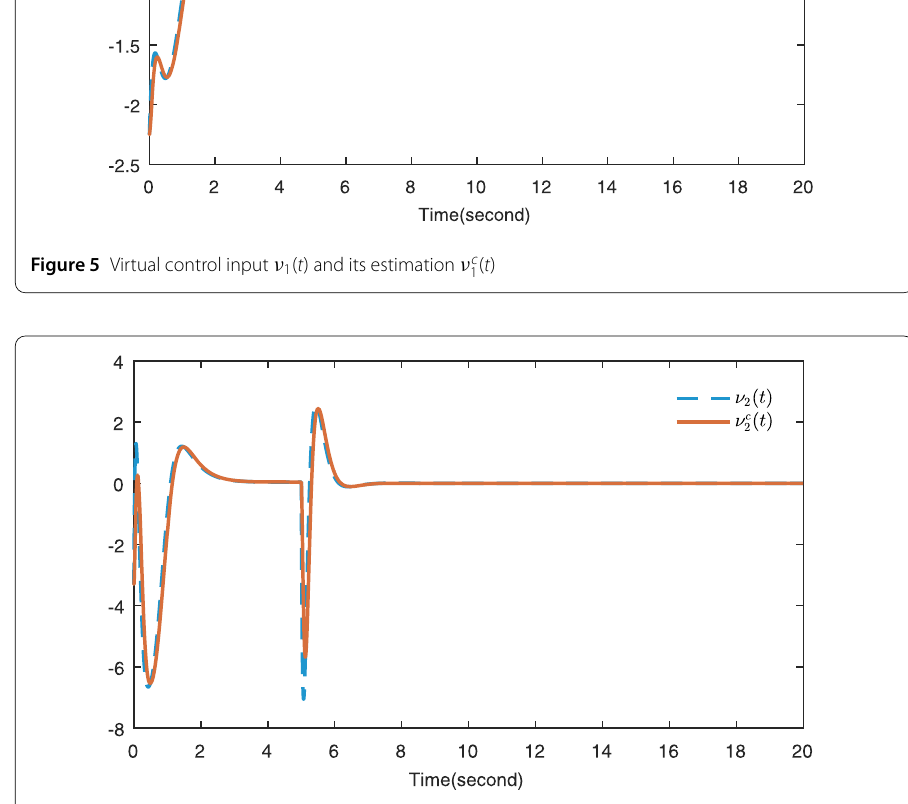
Figure 6 Virtual control input ν 2 ( t ) and its estimation ν c 2 ( t )